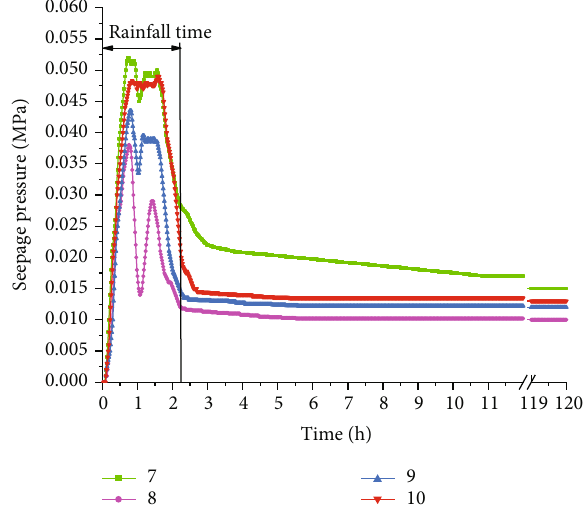
Figure 24: The changes of the seepage pressure on the tunnel vault with